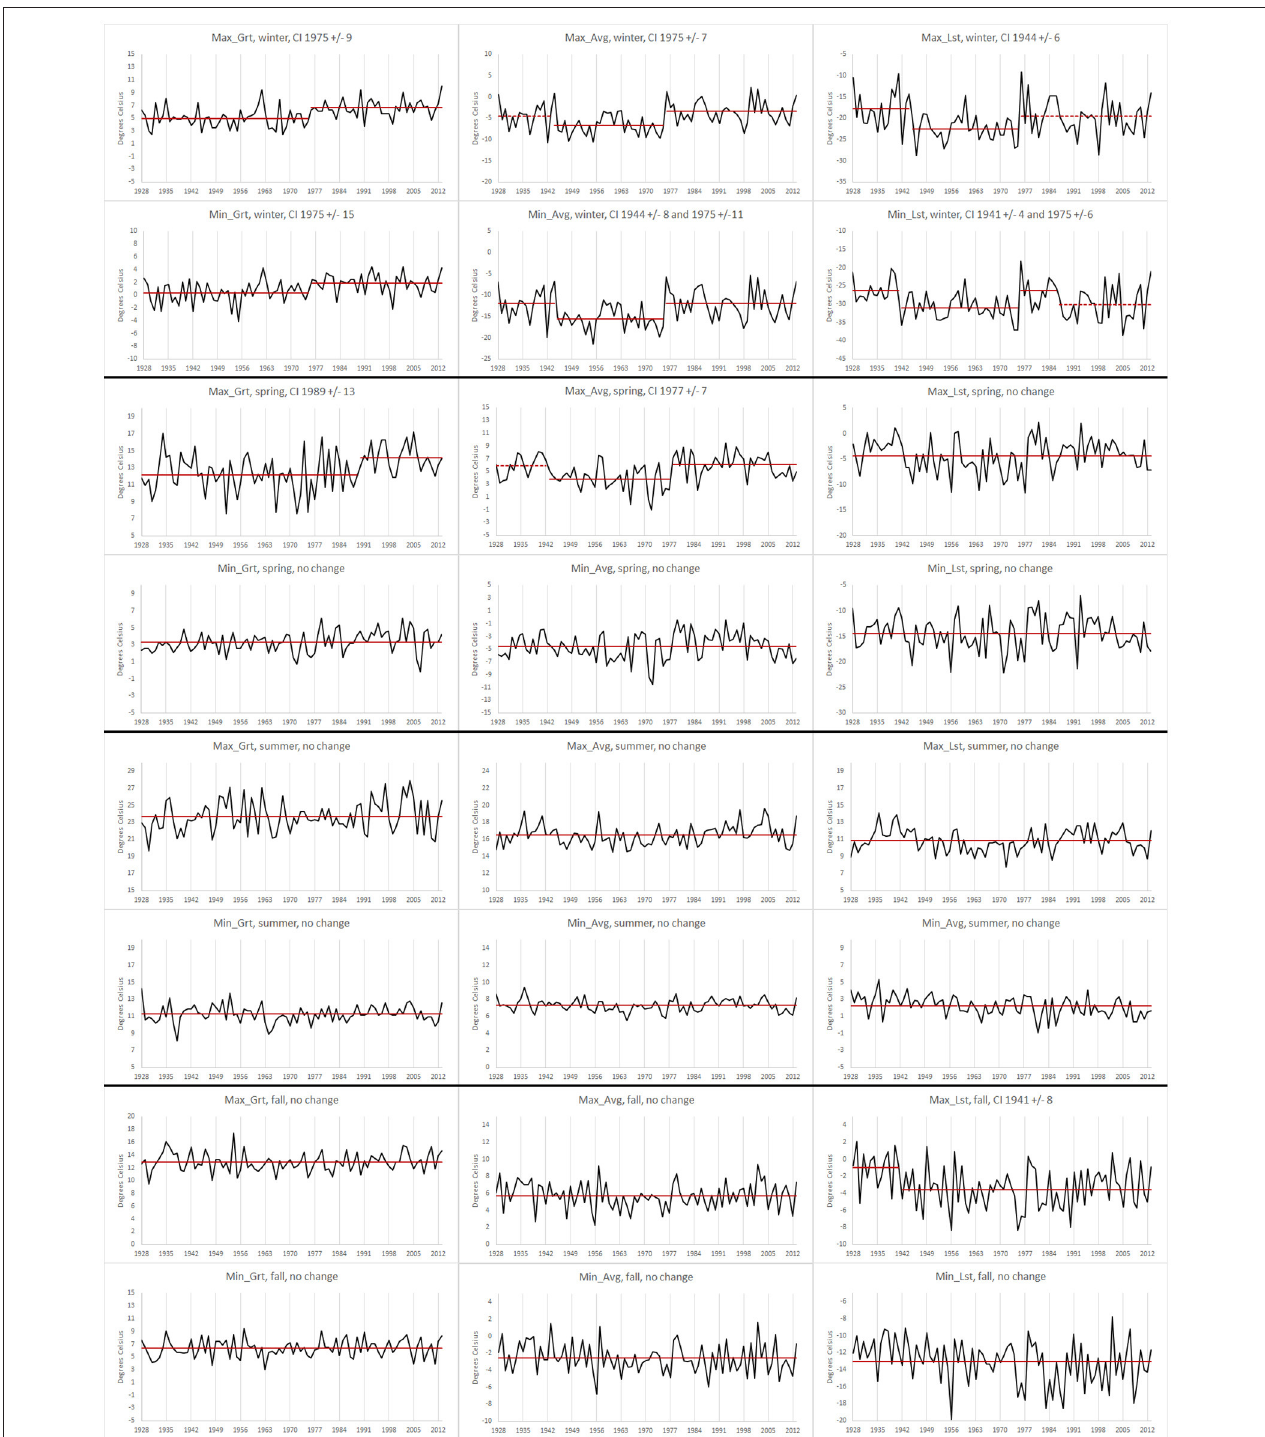
FIGURE 5 | KSA temperature data series for the time-period 1928–2013 for variables Max_Grt, Min_Grt, Max_Avg, Min_Avg, Max_Lst, and Min_Lst for winter ( A : Rows 1–2), spring ( B : Rows 3–4), summer ( C : Rows 5–6), and fall ( D : Rows 7–8) together with data means within each segment, where each segment is determined by change-point analysis; solid red lines represent data means within each segment with shifts identified by both the PELT method and the change detection test statistic; dashed red lines indicate data means for segments identified by PELT method but not confirmed by the change detection static when at least one other change is detected by both